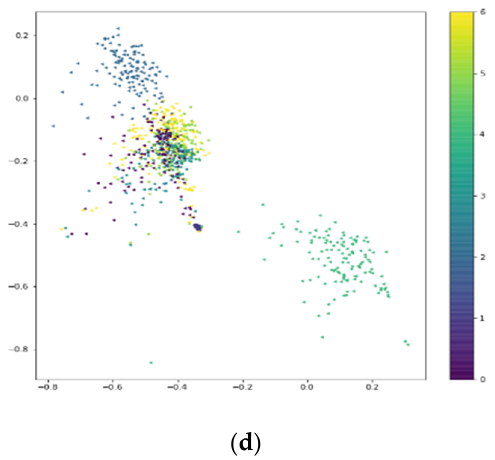
Figure 7. The outputs of unidimensional Convolutional Auto-Encoder (CAE) corresponding to generated signals with different training epochs. ( a ) When epoch = 500; ( b ) when epoch = 2000; ( c ) when epoch = 5000; ( d ) when epoch = 20,000.